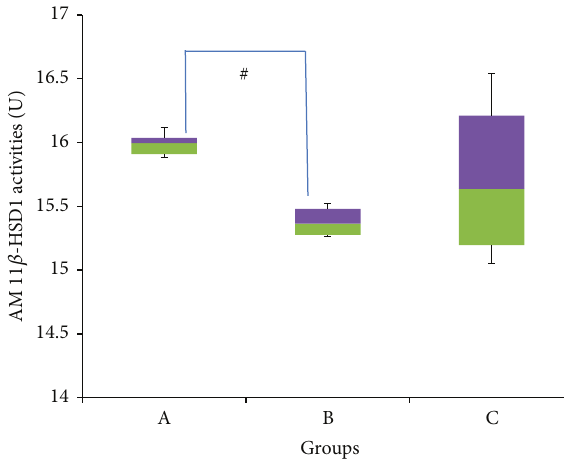
Figure 14: 11𝛽 -HSD 2 activities in the visceral adipose tissue of rats in groups A, B, and C at the end of the four-week treatment period. # Significant difference ( 𝑃 < 0.05 ) between denoted groups.